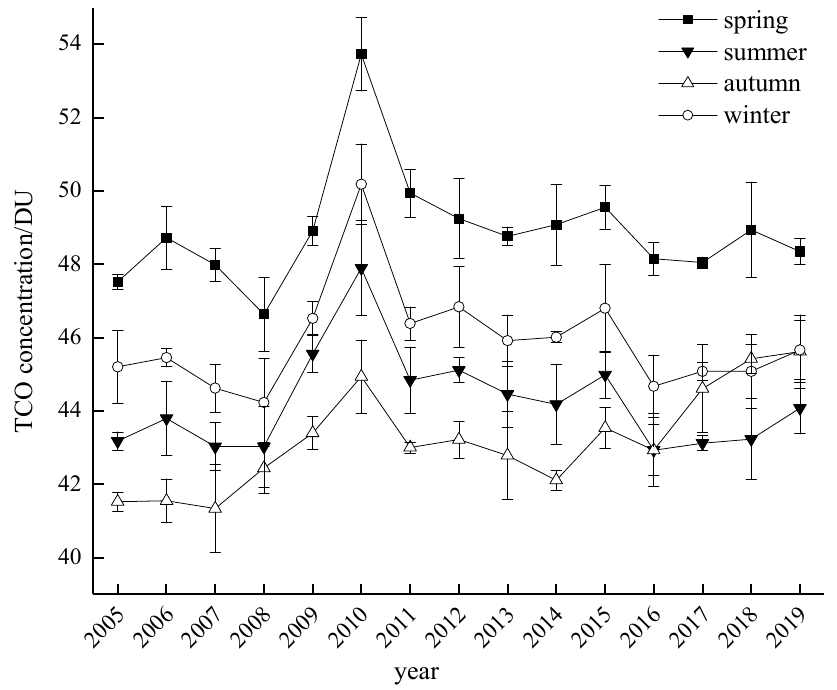
Figure 5. The seasonal variation characteristics of TCO concentration in China (mean ± se).